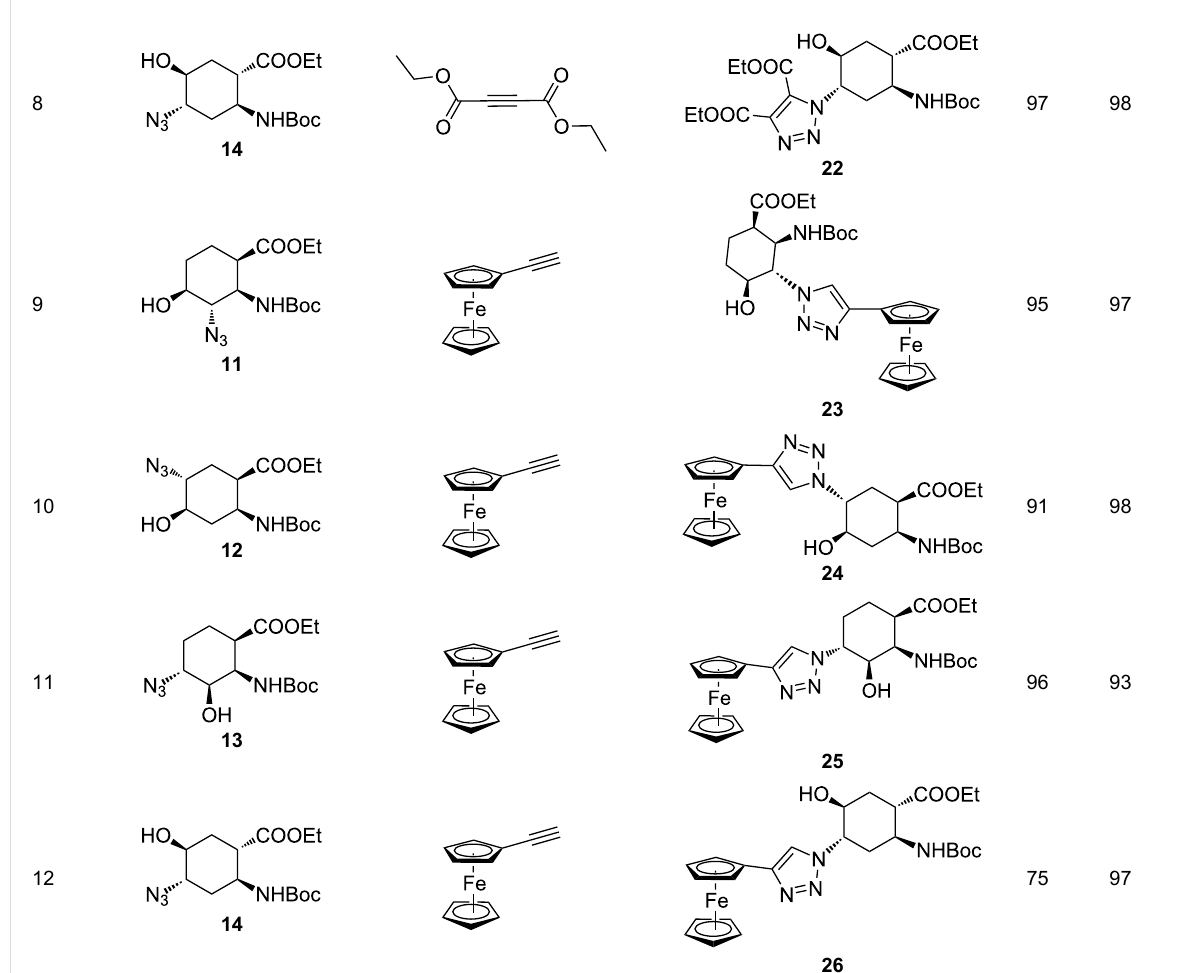
Table 1: CF synthesis of 1,2,3-triazole-substituted alicyclic β -amino acid derivatives.